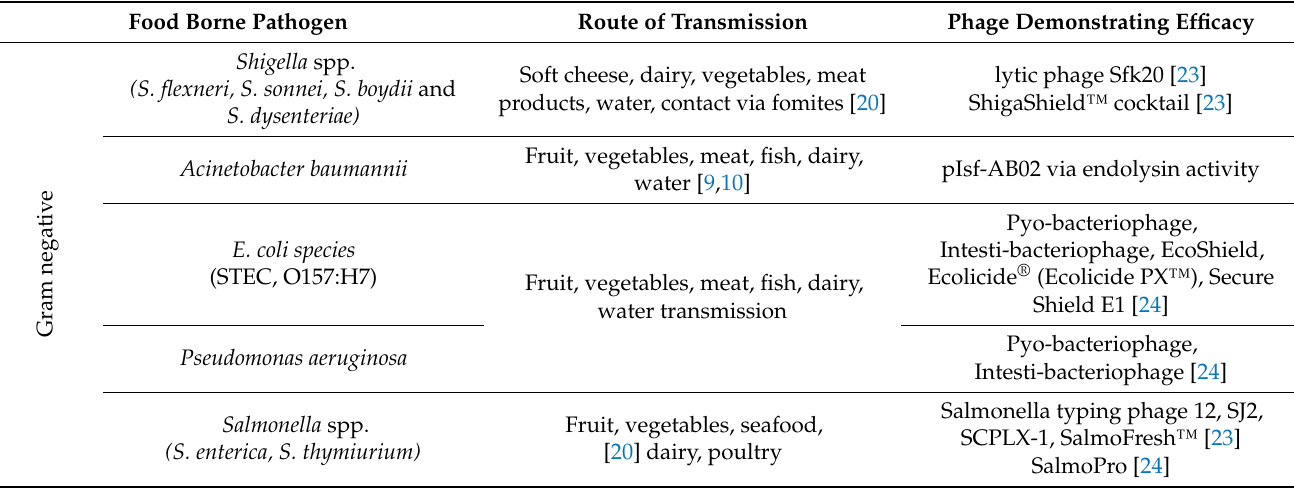
Table 1. Bacteriophages as potential control measures for microbial food pathogens. Food Borne